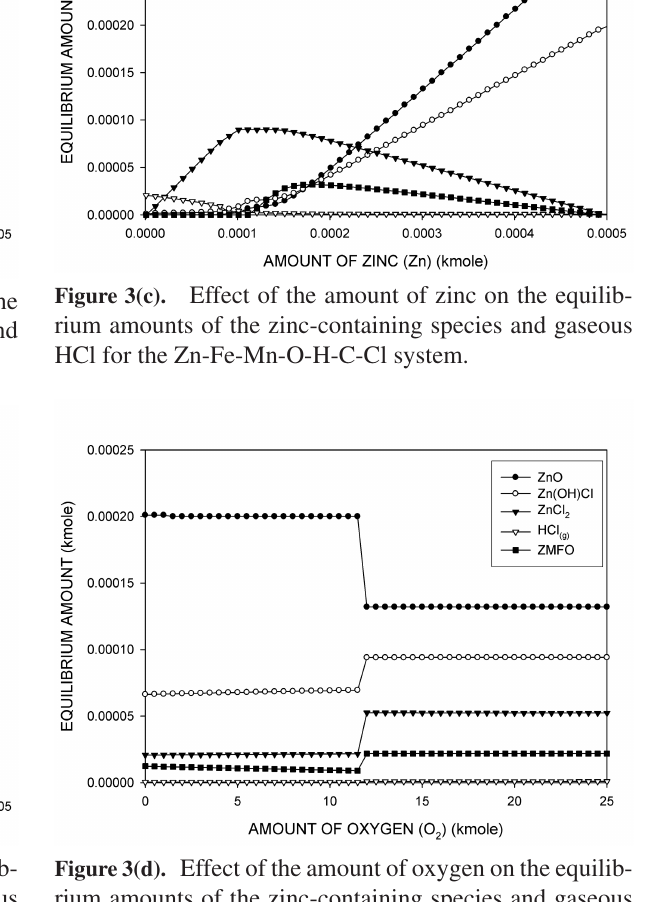
fect of the amount of calcium oxide in the dust on the amounts of the condensed zinc-containing species and also hydrogen chloride gas at a temperature of 298 K. The stan- dard conditions were utilized and the amount of chlorine gas (Cl 2 / was 1 (cid:4) 10 (cid:3) 4 kmole. It can be seen that the amounts of ZnCl 2 , Zn(OH)Cl and also HCl(g) decrease rapidly with increasing calcium oxide addition, while con- versely there is increased formation of ZnO. It is noteworthy that some Zn(OH)Cl exists even at calcium oxide additions above 1 (cid:4) 10 (cid:3) 4 kmole. Figure 4(b) shows the behaviour of the calcium-containing species. The amount of calcium chloride hexahydrate (CaCl 2 (cid:2) 6H 2 O) initially increases but then levels off and at this point the amount of calcium car- bonate becomes significant and continues to increase with increasing calcium oxide. This reduces the amount of chlo- rine available to react with